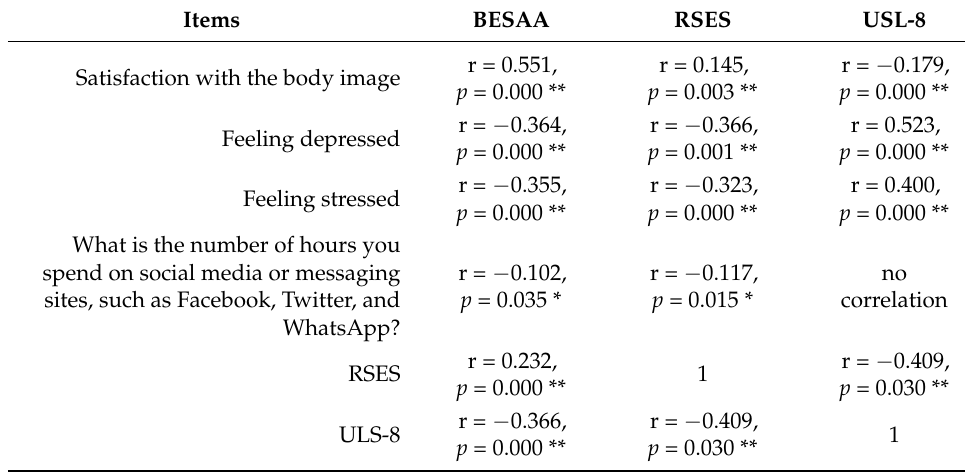
Table 5. Correlation analysis